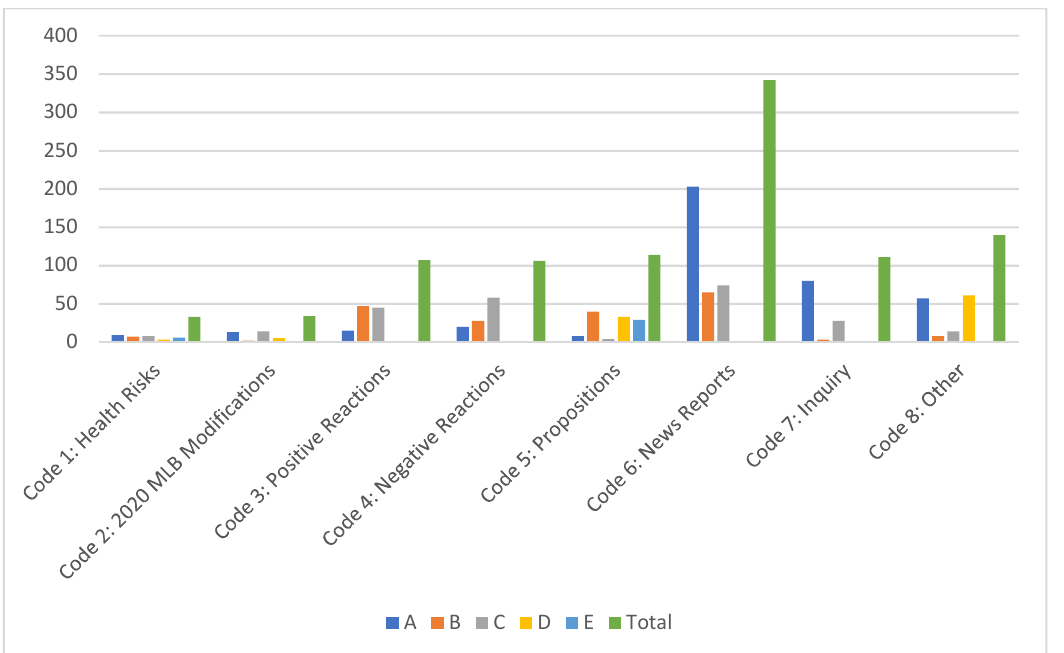
Figure 1. Frequency of tweets by category.